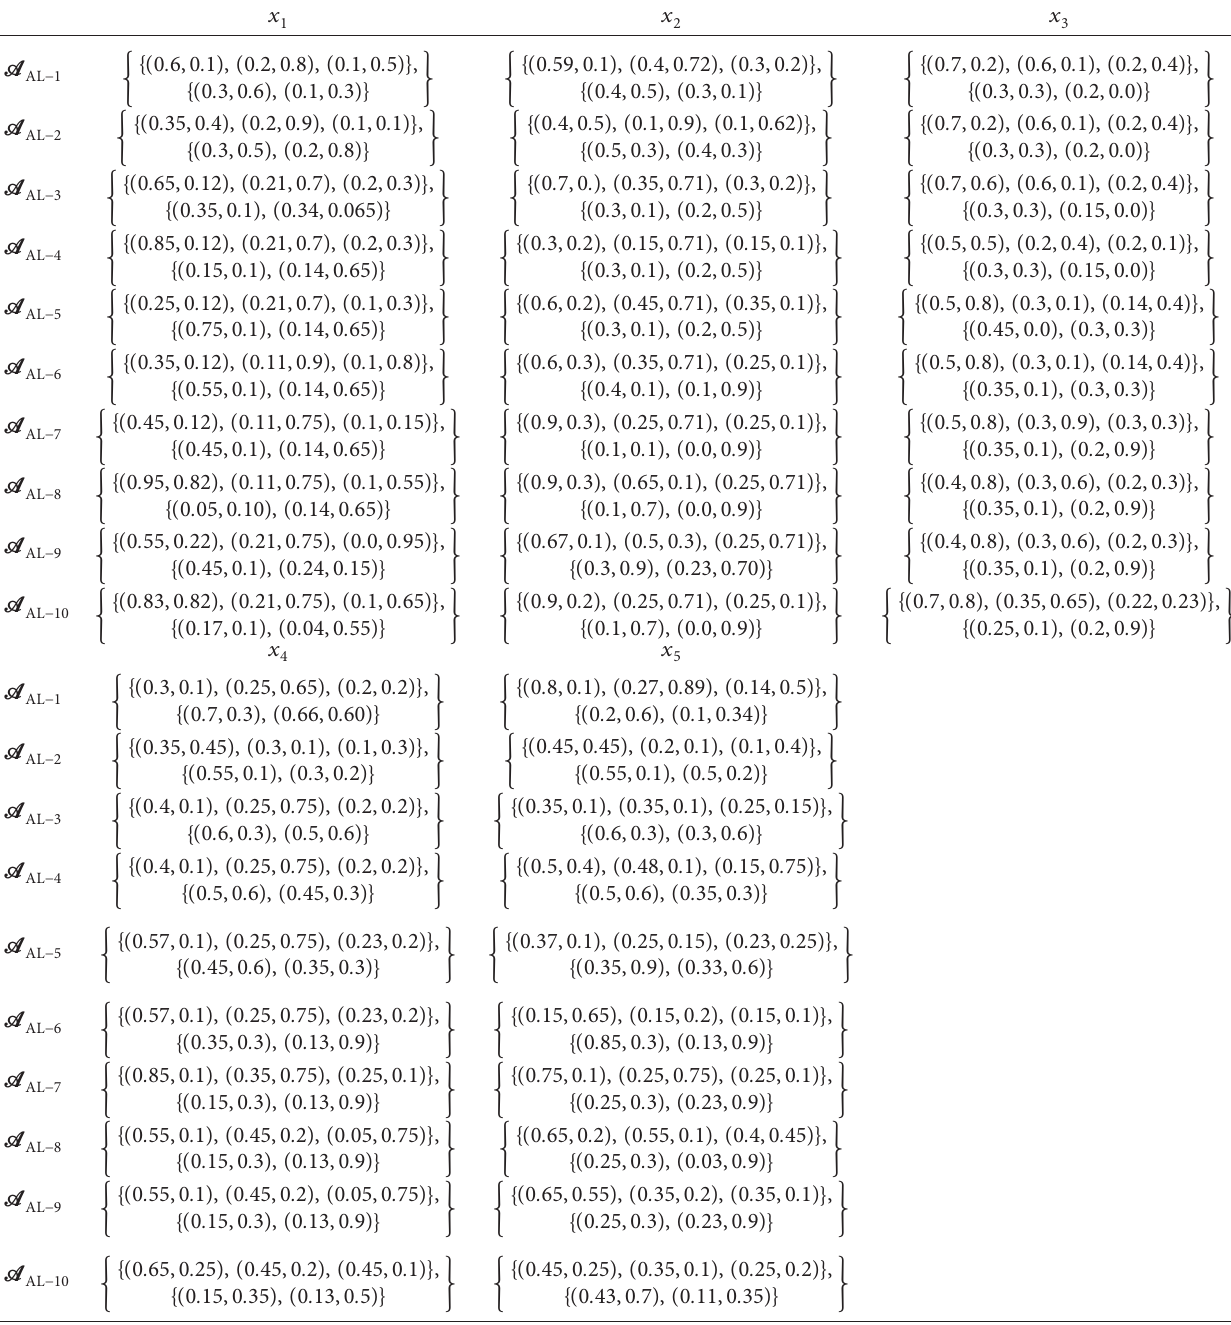
Table 6: Common evaluations of alternatives performed by